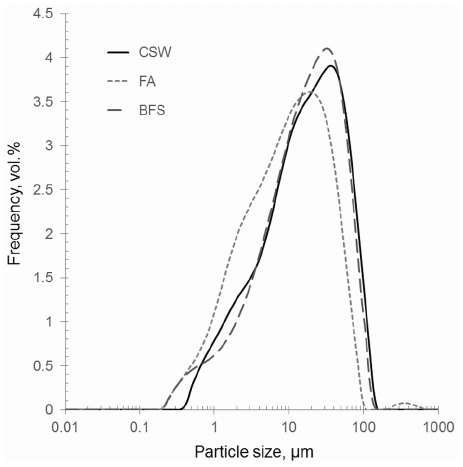
Figure 1. Granulometric distribution of the milled CSW, BFS, and FA particles. Table 3. Main granulometric parameters of the milled waste materials.